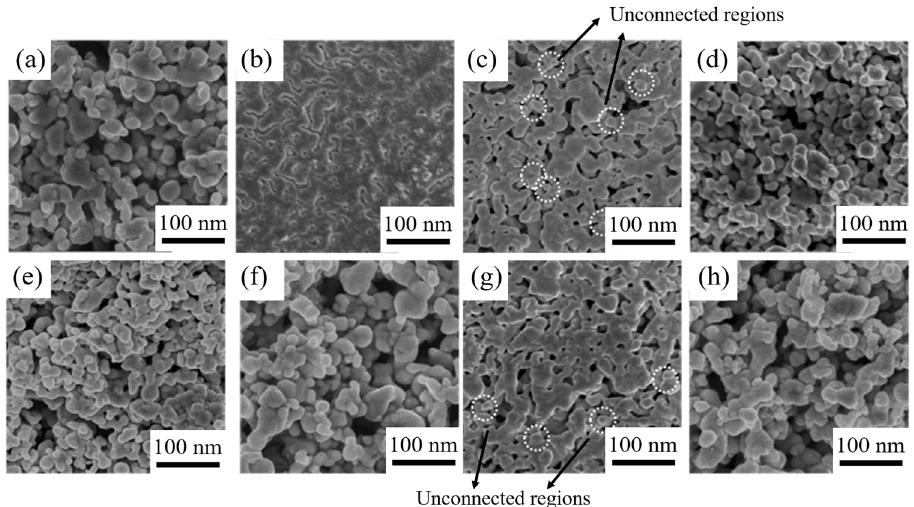
Figure 9. Morphology of Ag-sintered films of different composite pastes with: ( a ) MOD1, ( b ) MOD2, ( c ) MOD3, ( d ) MOD4, ( e ) MOD5, ( f ) MOD6, ( g ) MOD7, ( h ) pure Ag powders.